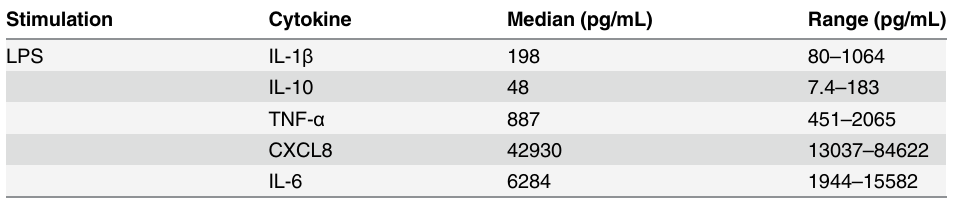
Table 1. Median and range of DMSO controls from LPS-stimulated PBMCs (n = 6 cultures in